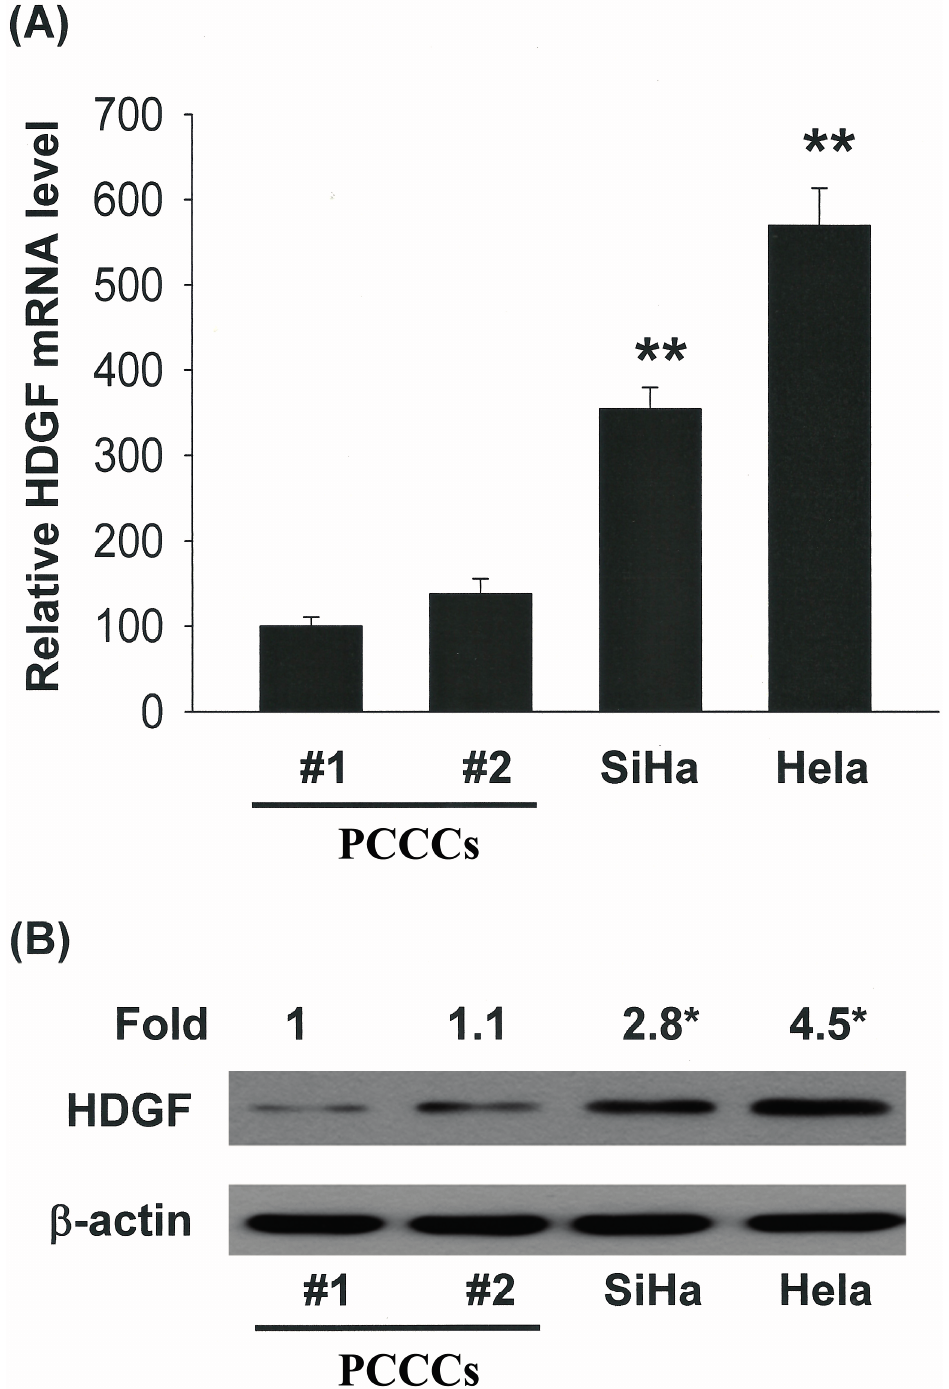
Figure 3. HDGF mediated the survival of cervical cancer cells, thereby increasing proliferation/growth. Correlation of HDGF expression with the tumorigenic behaviors of cervical cancer cells. ( A ) qRT-PCR and ( B ) immunoblot analysis of HDGF protein level in human cervical cell lines. All data are reported as the mean (±SEM) of at least three separate experiments. Statistical analysis was performed using a t -test, with significant differences determined at the level of * p < 0.05 and ** p < 0.01 versus the control group (HDGF 0 nM